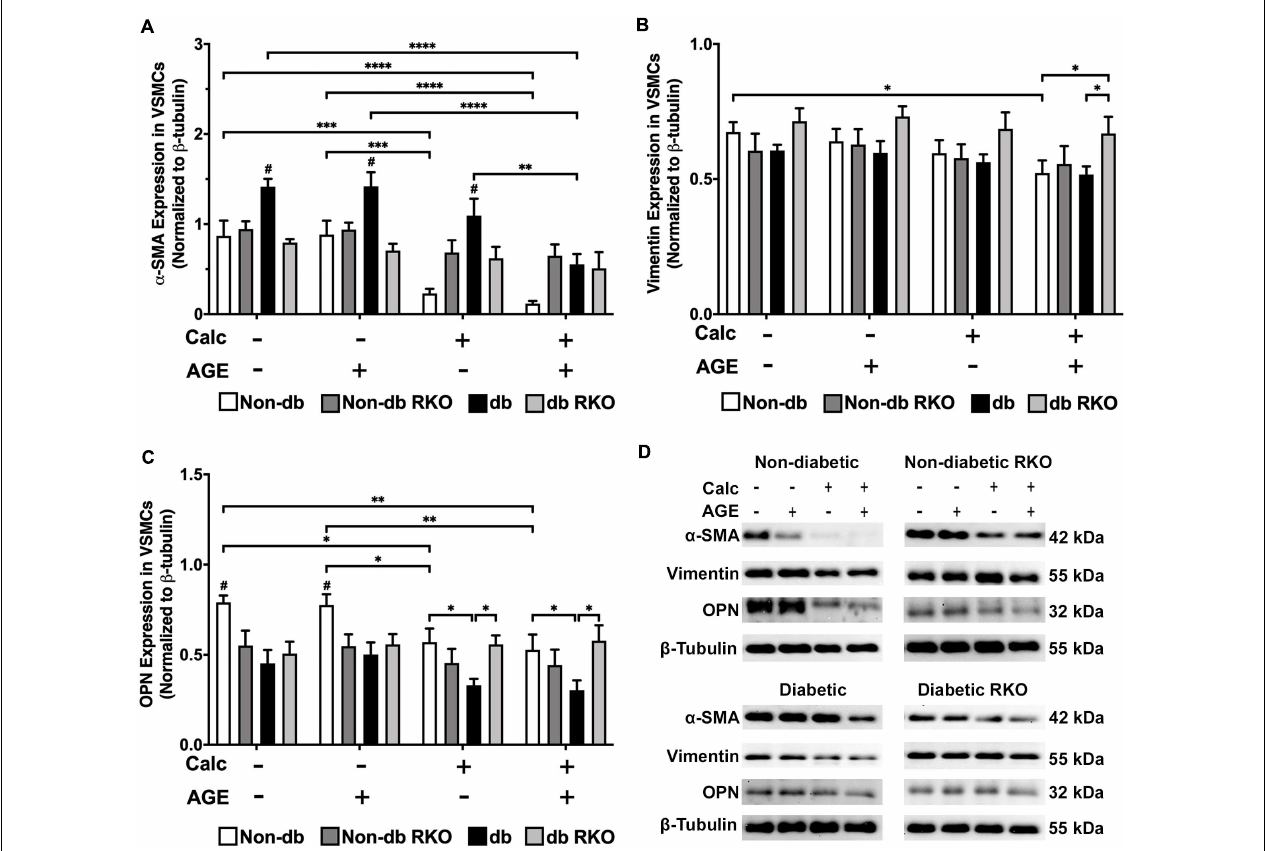
FIGURE 2 | Vascular smooth muscle cells respond to calcification by differentiating away from the contractile phenotype and toward a different cell type. Protein expression of α -SMA (42 kDa; A ), vimentin (55 kDa; B ), and OPN (32 kDa; C ) was quantified. Non-diabetic, non-diabetic RKO, diabetic, and diabetic RKO primary VSMCs were isolated and treated with 3 mM P i with or without AGEs (0.5 mg/mL) for 7 days. Protein levels were normalized to β -tubulin (D) and graphed as mean ± SEM with n = 6–9 of independent replicates. Statistical analysis consisted of a two-way ANOVA and a Fisher’s LSD test post hoc ( # p < 0.05 toward all other groups in treatment group, * p < 0.05, ** p < 0.01, *** p < 0.001, **** p <